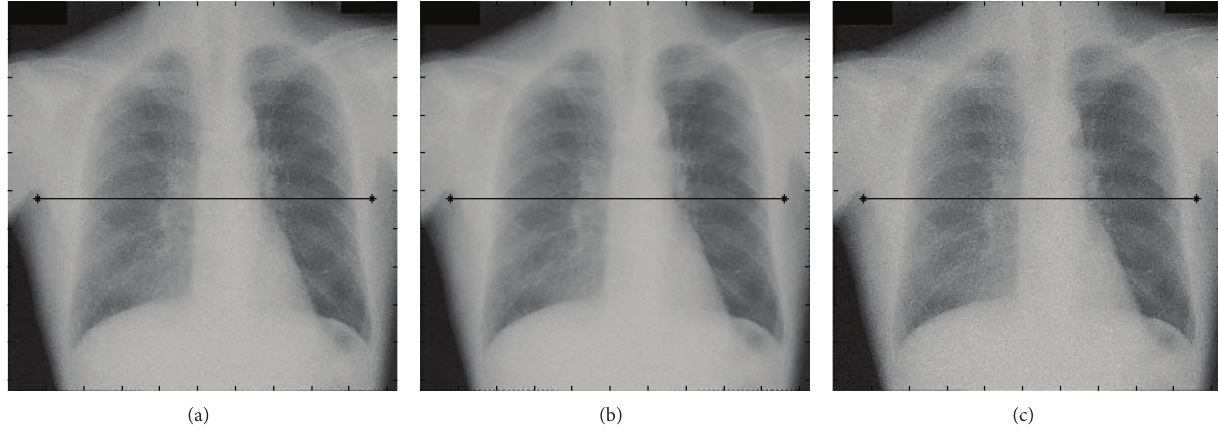
Figure 5: Image processing results for chest radiographs. (a) Image processed by the proposed method, (b) image processed by the modified UDWT method, and (c) image processed by the sigmoid-type wavelet coefficient mapping method.